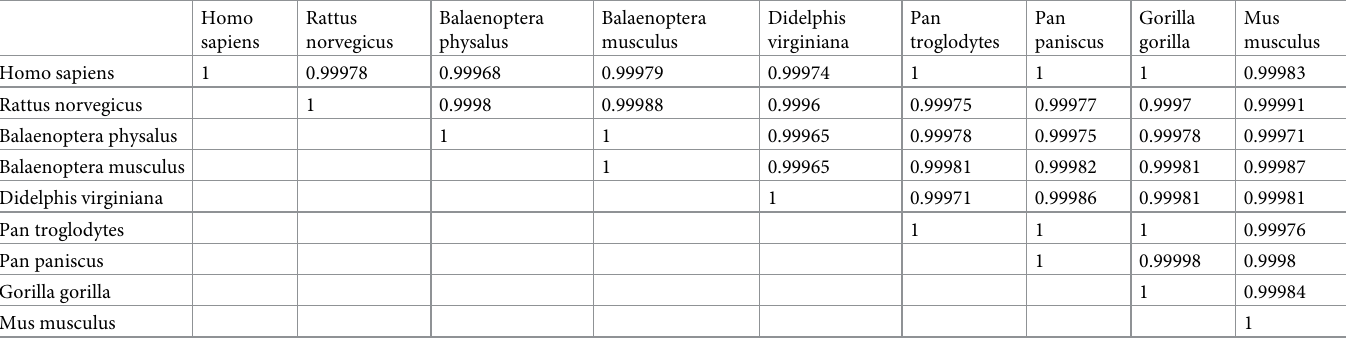
Table 10. The parameter Accuracy (Acc) of the HELIOS method with referencing the Smith-Waterman algorithm in the accuracy measurement of classification output. The assumed dataset is the “Nine ND5 protein sequences dataset” [53] in this